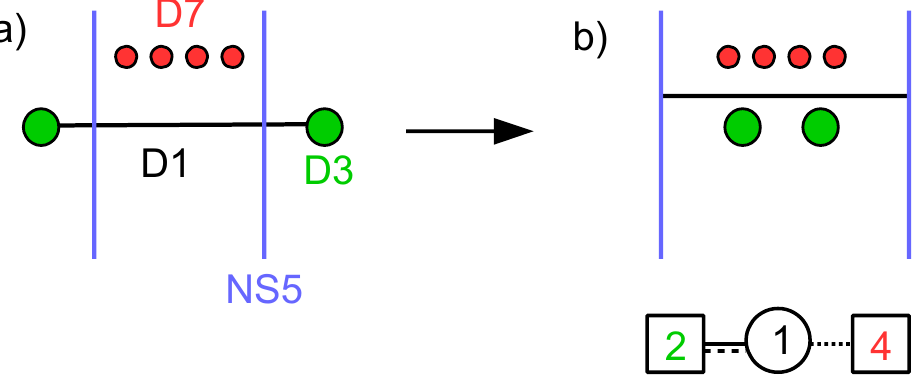
Figure 3 . Bubbling con(cid:12)guration for the minimal ’t Hooft loop in SU(2) with N f = 4 (cid:13)avors. The ADHM quiver is read after moving the NS5 branes to the